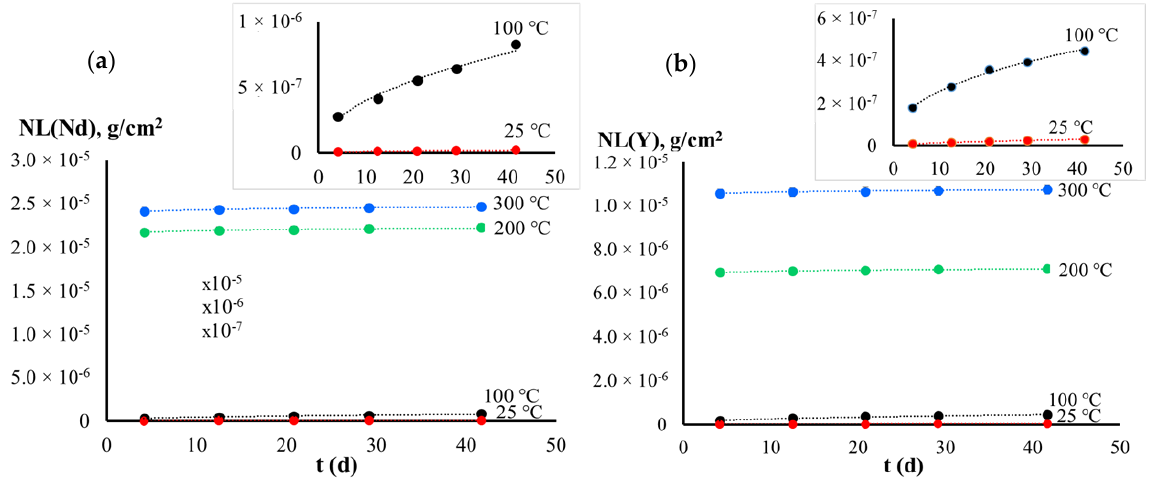
Figure 5. The normalized weight loss NL i vs the time t for Y ( a ) and Nd ( b ).